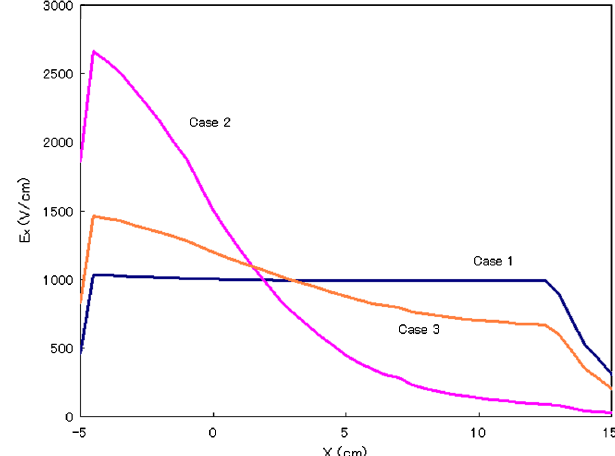
FIG. 18. Horizontal component of the electric field E x at the center of the kicker electrode ( y ¼ z ¼ 0 ) vs x . In case 1 the subsidiary electrodes share the voltage equally. In case 2 each subsidiary electrode is floated. In case 3 all subsidiary electrodes are